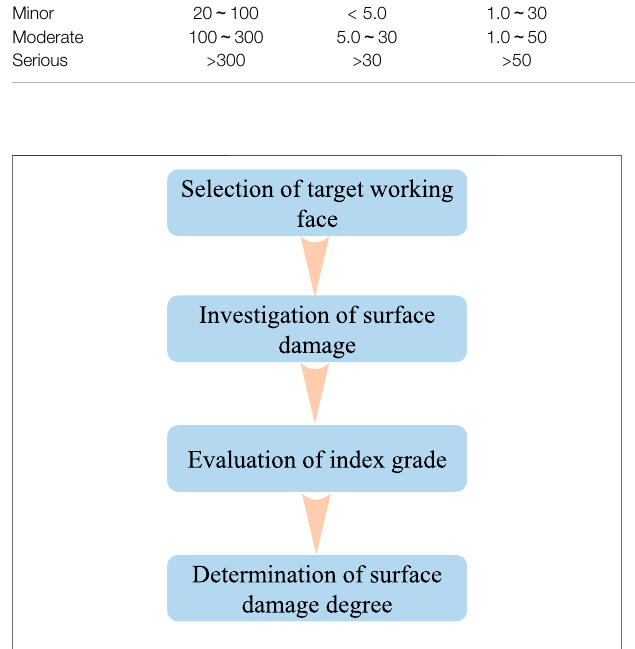
FIGURE 5 | Evaluation process of the surface damage degree.